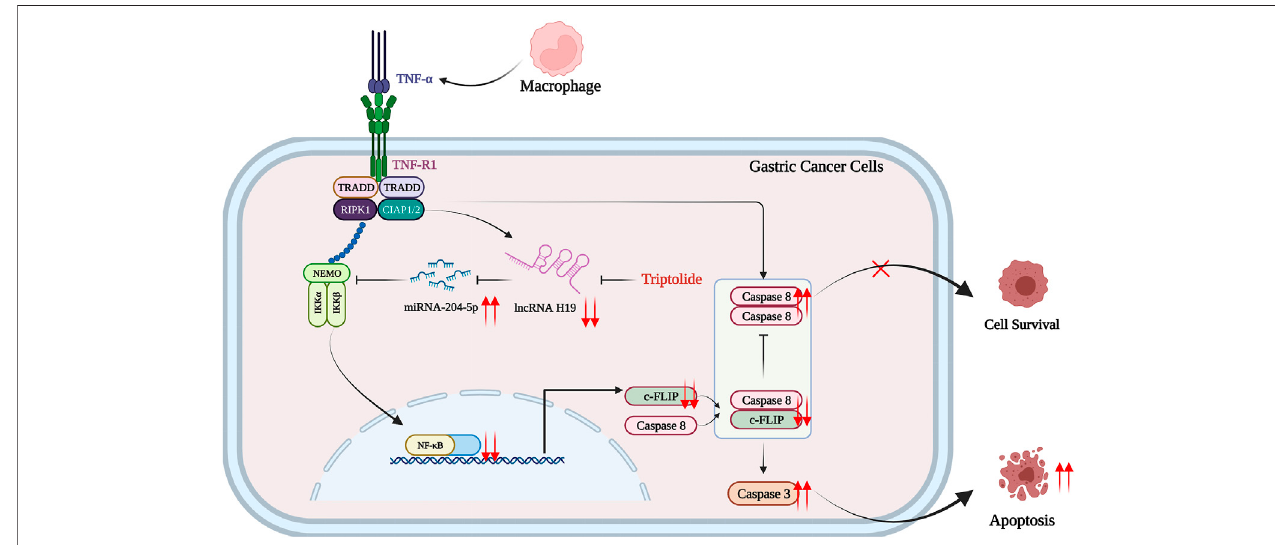
FIGURE 8 | Schematic presentation indicating the suggested mechanisms by which TP/TNF- α – induced gastric cancer cell death. Under a physiological state, a low dose of TNF- α stimulates both cell survival signals via H19/miR-204-5p/NF- Κ b/FLIP pathway and cell death signals via activating caspase-8. The upregulation of FLIP inhibits caspase-8-dependent apoptosis, and the consequence of a low dose of TNF- α is cell survival. However, TP pretreatment inhibited H19/miR-204-5p/NF- κ B/FLIP signals, and the insigni fi cant level ofFLIP could notcounteract theprodeath signals induced by TNF- α , leadingtogastric cancer cell death. The fi gure was created using BioRender.com (Agreement number: